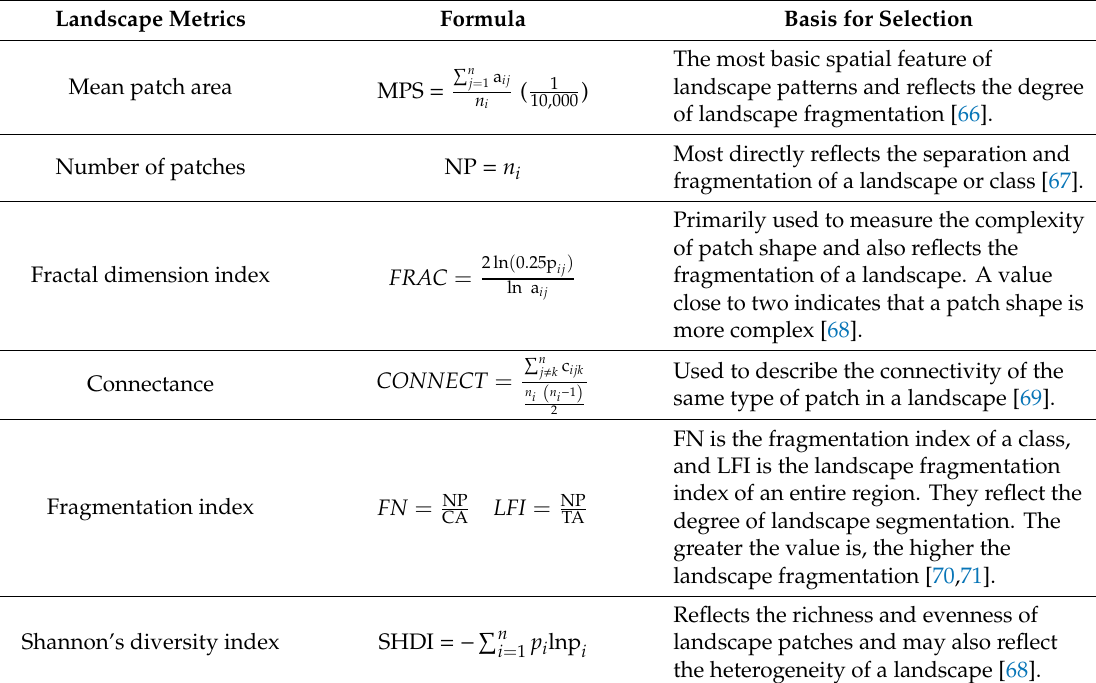
Table 3. Main landscape indices